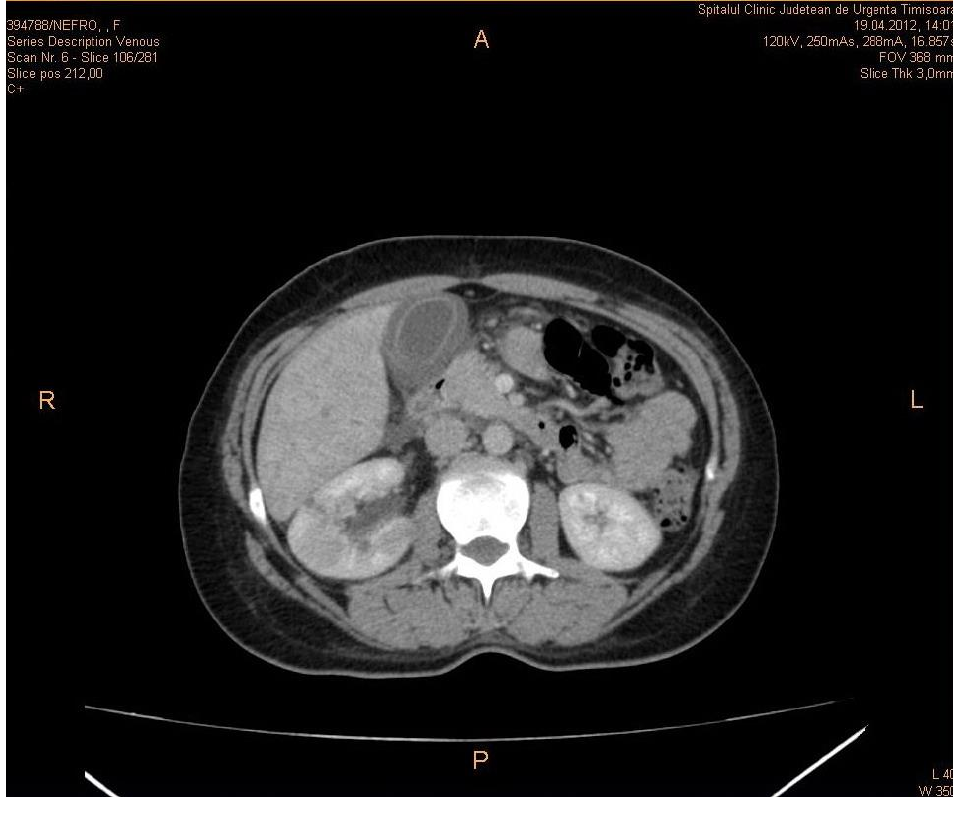
Figure 1. Contrast-enhanced CT scan of a patient in the venous phase showing kidney abscesses associated with acute acalculous cholecystitis.